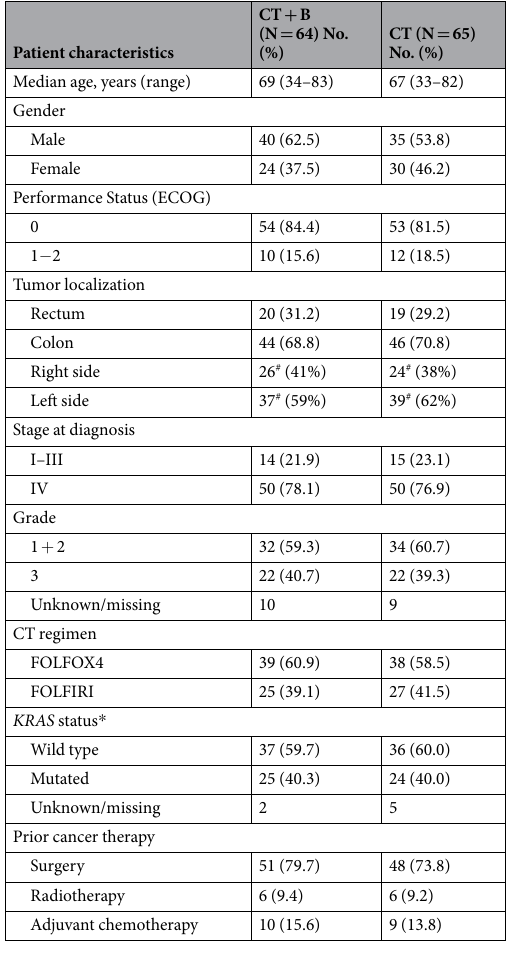
Table 1. Patient characteristics. CT, chemotherapy; B, bevacizumab. * Required by amendment no. 1 of 3 rd May 2009; # Information about which side of the colon was involved was not available for one patient in the CT + B group and 2 patients in the CT